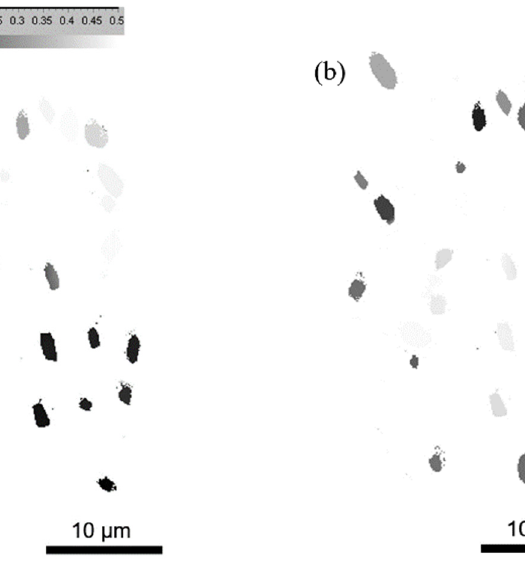
Figure 9. The distribution of SF for different types of slip systems ( a ) basal <a> type, ( b ) prism <a> type and ( c ) pyramidal <a+c> type.